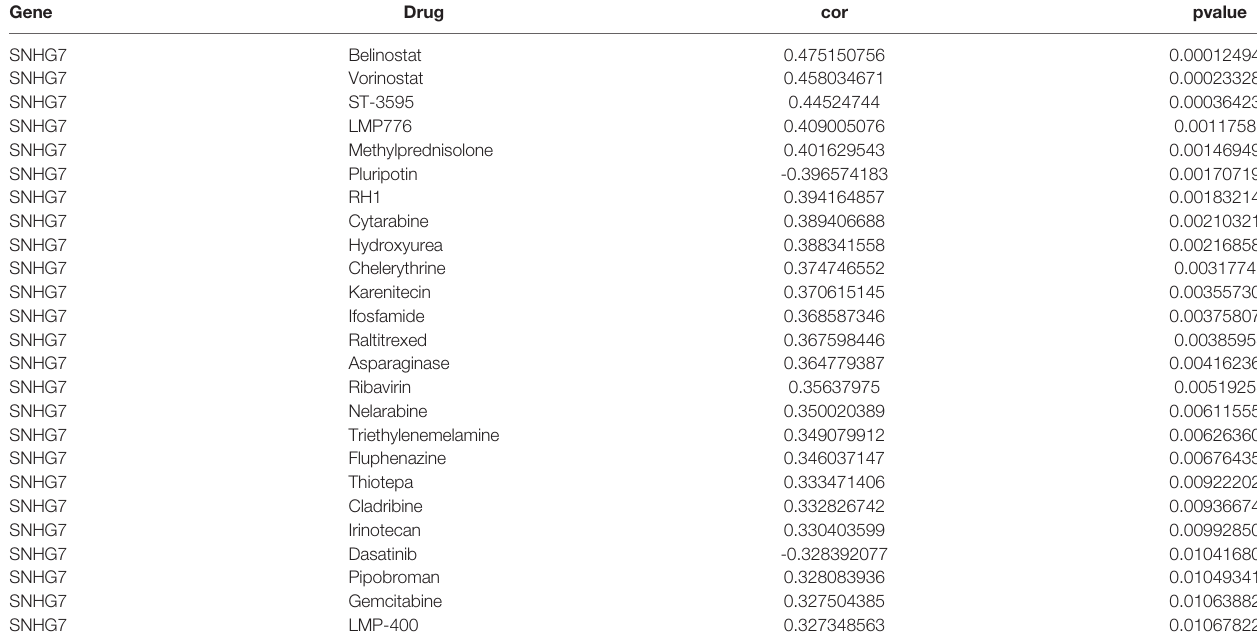
TABLE 3 | Drug Sensitivity Analysis of SNHG7.